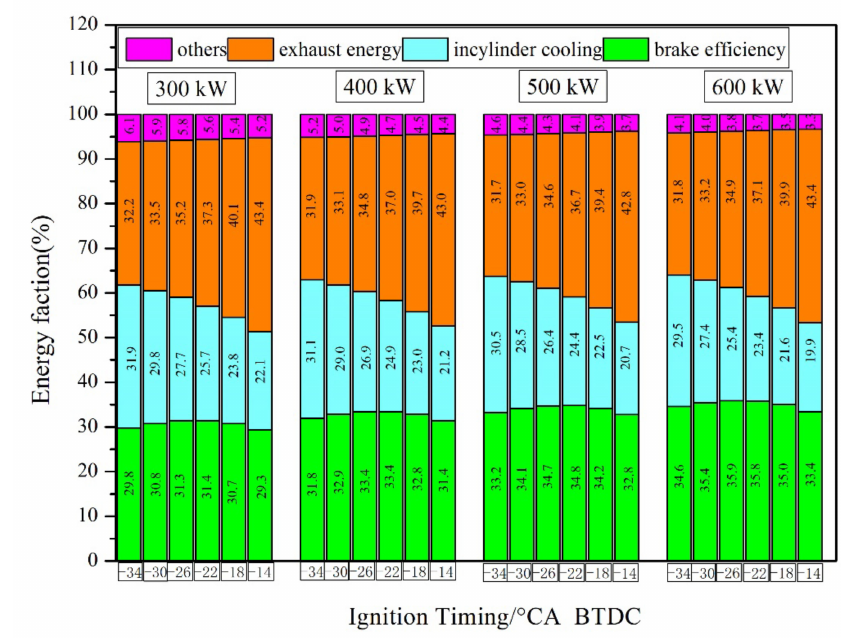
Figure 8. Influence of ignition advance angle on energy